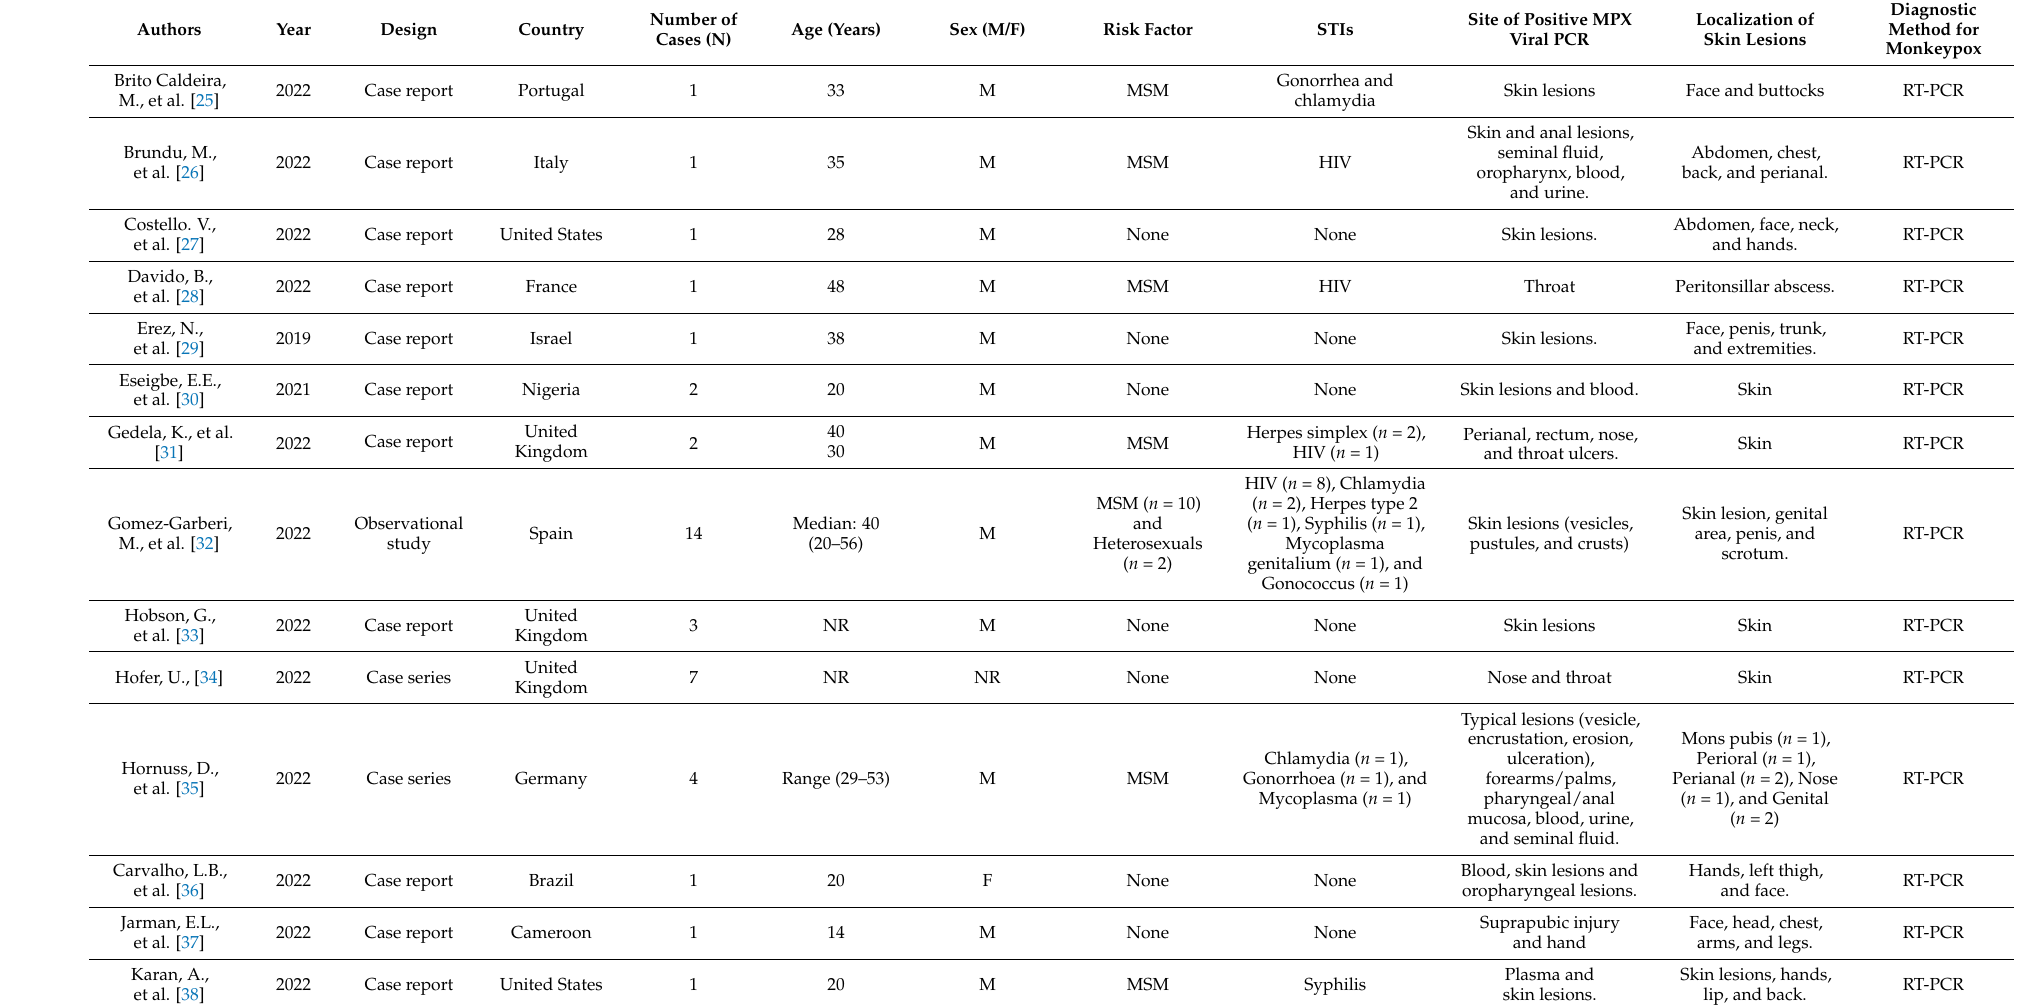
Table 2. Characteristics of included studies and description of case reports of